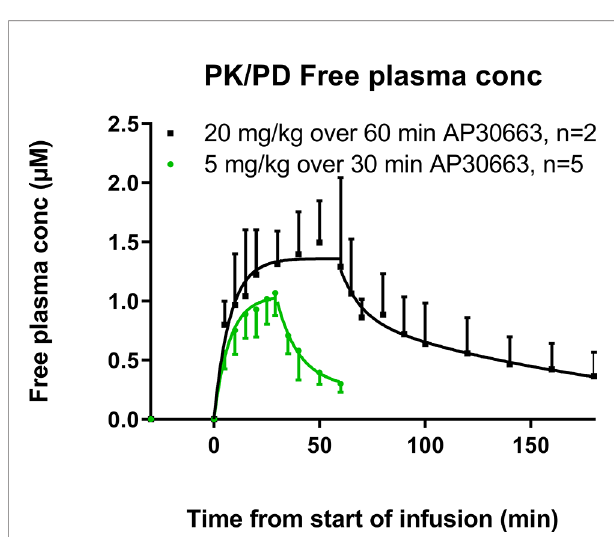
FIGURE 6 | Free plasma concentrations of AP30663 at different time points before, during, and after infusion. The plasma concentrations during infusion were fi tted as a one phase association with this formula: C = C0 + (Plateau − C0) * [1- exp( − K * T)], where C is the plasma concentration, T is time, and K is the elimination rate constant with two constraints: that the initial concentration (Y0) must be zero and K must be shared between the two data sets. The plasma concentrations after the end of infusion were fi tted as a two-phase decay with this formula: C = C0 * PercentFast * 0.01 * exp( − Kd * T) + C0 * (100 − PercentFast) * 0.01 * exp( − Ke * T), where T is time, C0 is the concentration at T = 0, Kd is the distribution rate constant, Ke is the elimination rate constant, and PercentFast is the fraction of the span (from C0 to zero) accounted for by the faster of the two components. There were two constraints: the Kd- and the Ke-values must be shared between the two data